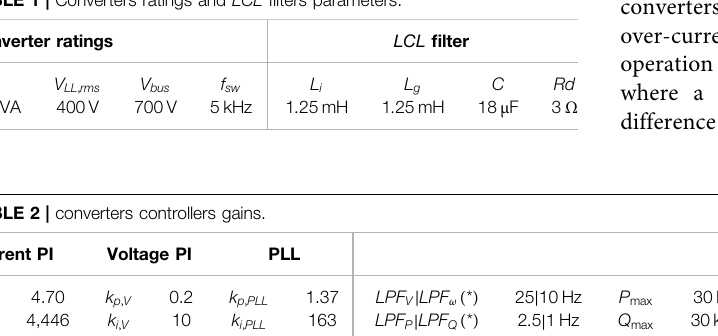
TABLE 1 | Converters ratings and LCL fi lters parameters.